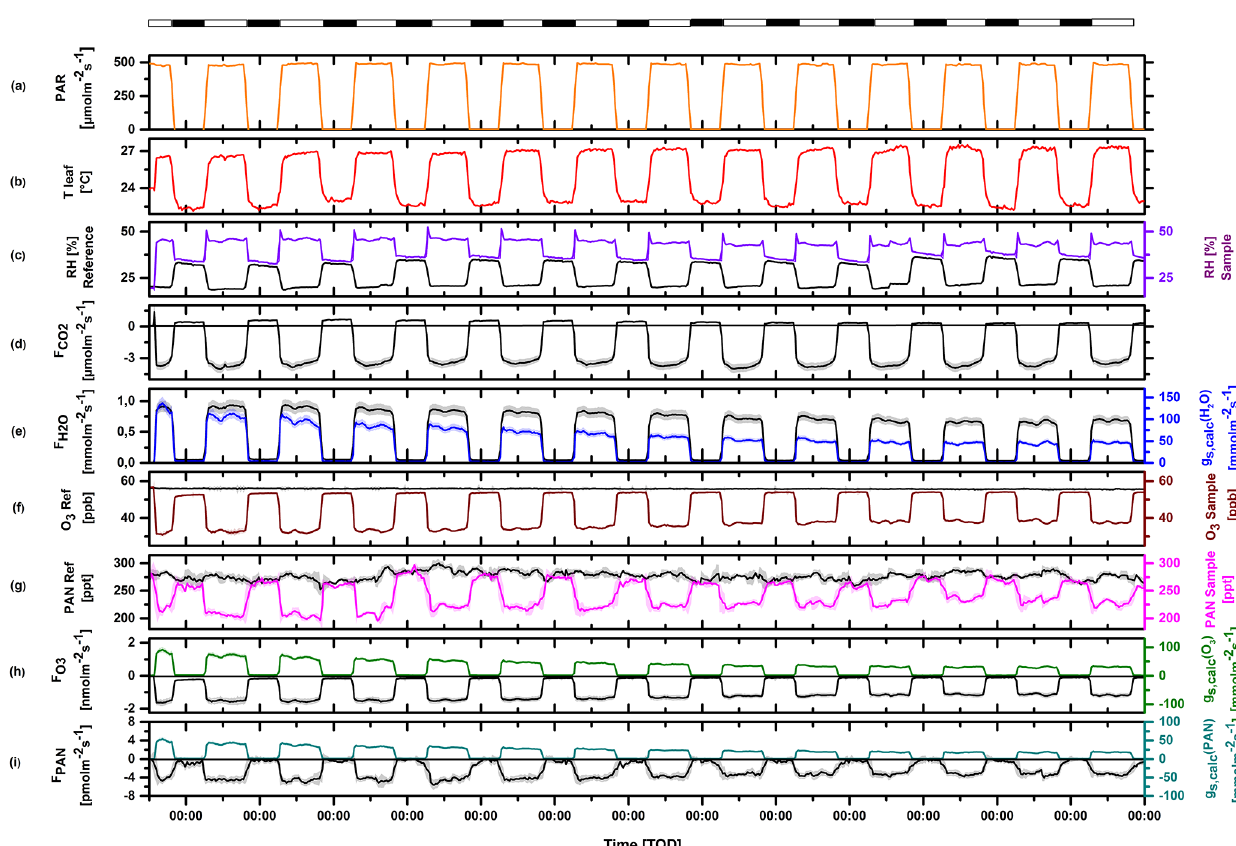
Figure 9. Long-term flux measurement of Quercus Ilex at constant initial mixing ratio (O 3 = 57ppb, PAN = 280ppt) over 14 days. (a) light density, (b) leaf temperature, (c) relative humidity of the reference (black) and sample (violet) cuvette, (d) CO 2 exchange flux, (e) transpi- ration rate (black) and stomatal conductance to water vapor (blue), (f) O 3 mixing ratio of the reference cuvette (black) and sample cuvette (brown), (g) PAN mixing ratio of the reference cuvette (black) and sample cuvette (magenta), (h) O 3 exchange flux (black) and O 3 conduc- tance (green), (i) PAN exchange flux (black) and PAN conductance (dark cyan). The diurnal cycle of light was simulated by a climate cabinet with 13h light period (white balk) and 11h dark period (black balk). The inner area of the cabinet had a temperature of 25 ◦ C and relative humidity of